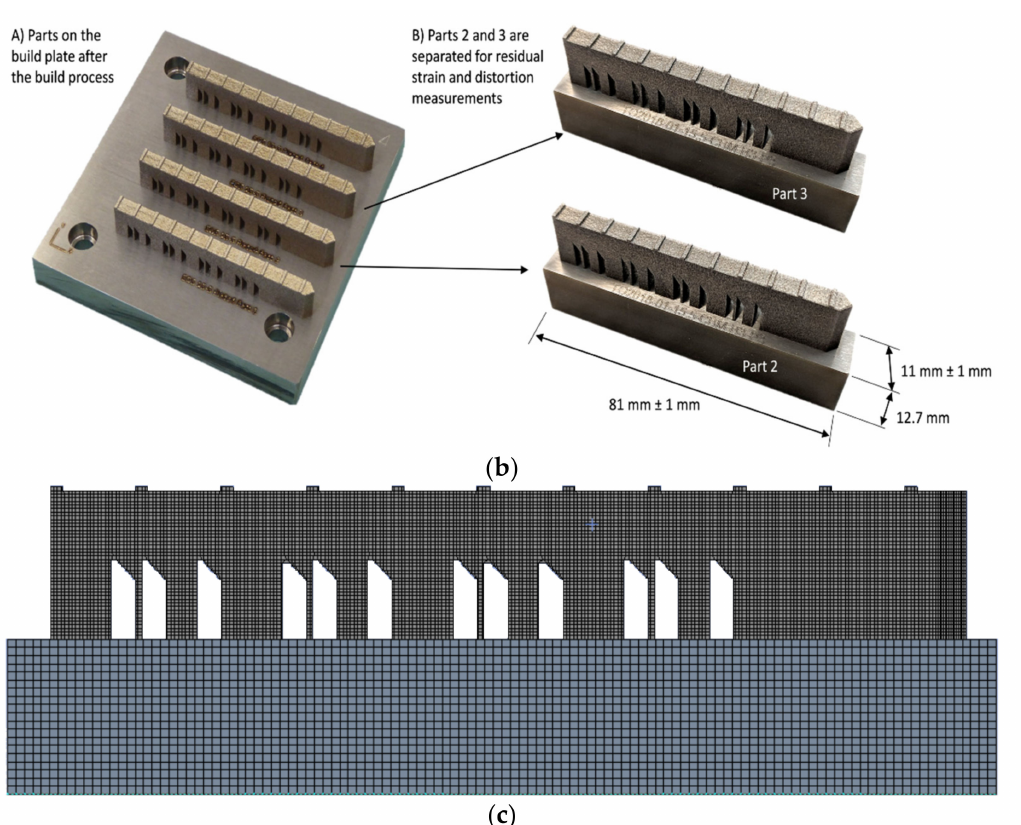
Figure 6. ( a ) Plan (top) and elevation (bottom) views of the AMB2018-01 bridge structure geom- etry, ( b ) AMB2018-01 bridge [9], and ( c ) AMB2018-01 bridge geometry constructed with Ansys additive software.